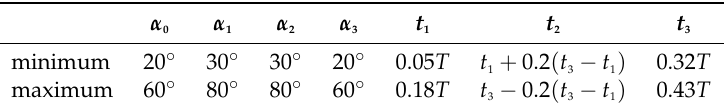
Table 2. Parameter ranges for the pitching